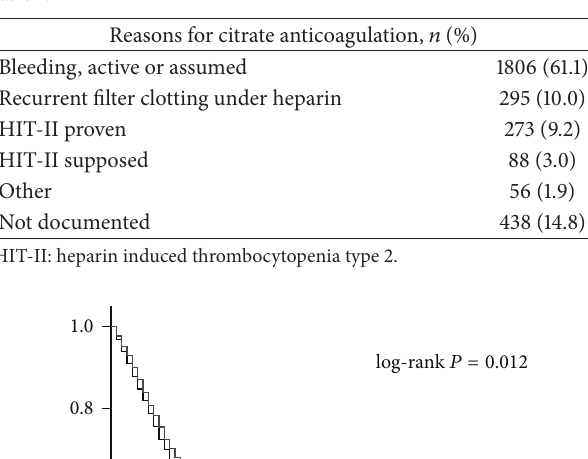
Table 4: Reasons for citrate anticoagulation among the study popu- lation.